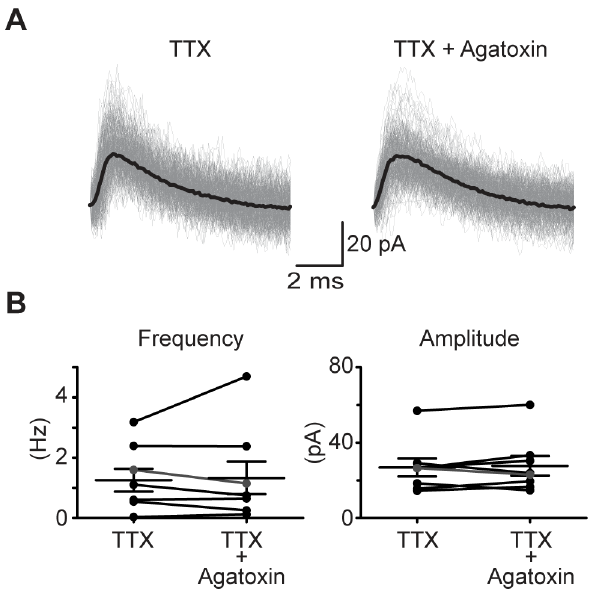
Figure 7. Spontaneous miniature events occur independent of P/Q activation. A ) Example miniature PSCs recorded in TTX, before and after v -agatoxin IVA, in a P12 slice. B ) Mean mPSC frequency (left) and amplitude (right) for each neuron recorded before and after P/Q block. N=8 cells, P12–15. Cell in A shown in gray.